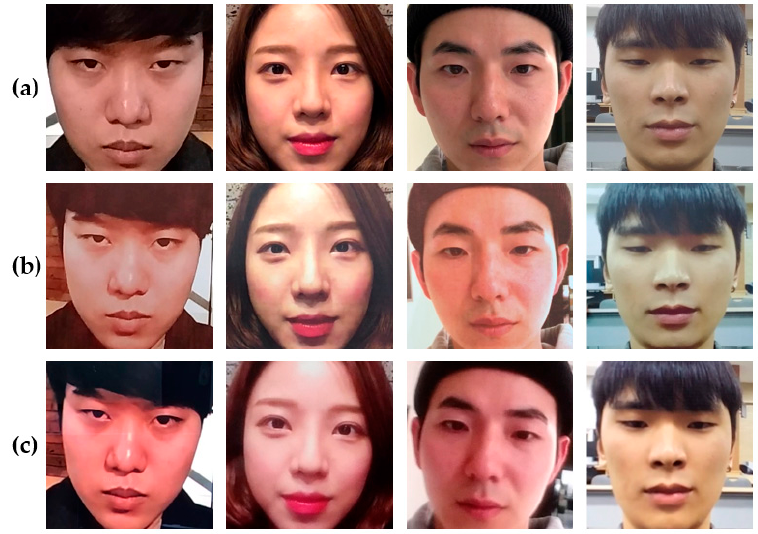
Figure 9. The results of face data preprocessing: ( a ) real; ( b ) printed photo; ( c ) replay video.